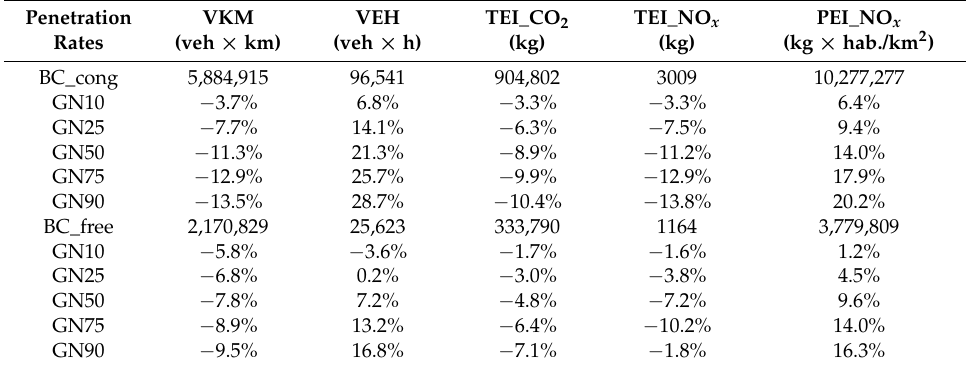
Table 2. Variation of traffic and environmental indicators for the whole regional network for each GN penetration